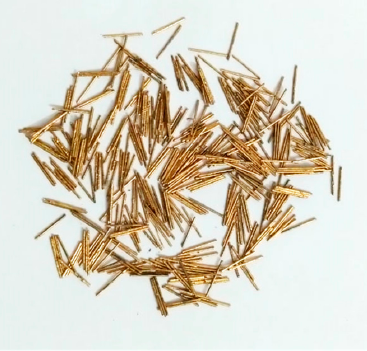
Figure 1. Steel fibers used for casting UHPC specimens. The mixing was ended when a uniform distribution of steel fibers was achieved without any fiber clumping. After mixing, tunnel segments having 1050 mm in length and 500 mm in width were cast on a vibratory table to achieve adequate consolidation. The crown height and thickness of the cast specimens was 110 mm (Figure 3). The selected size of the segments was a one-third-reduced replicate of the full-scale segments used in a real tunnel project in Toronto, Canada.